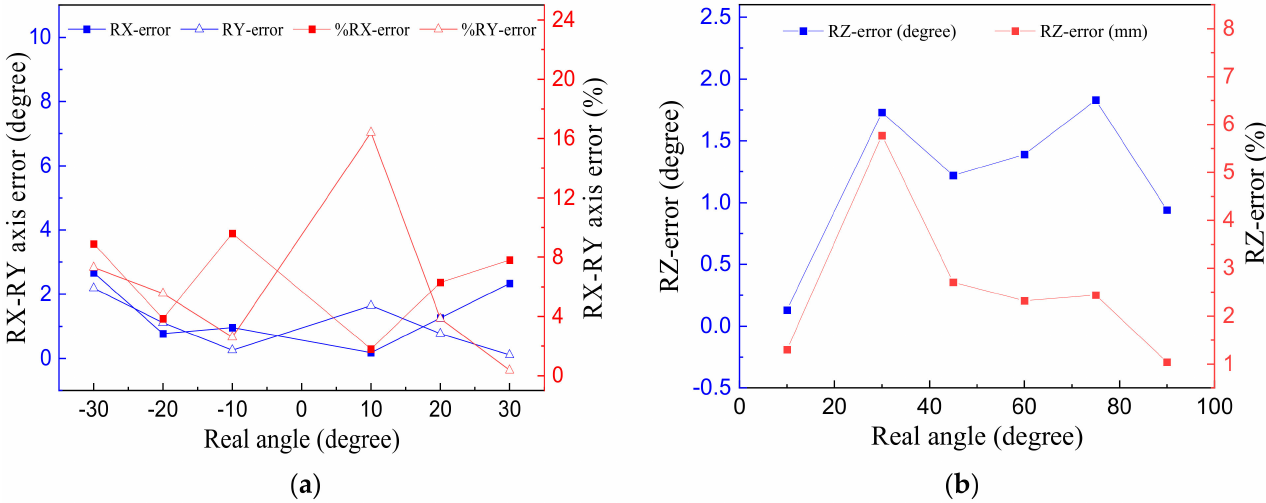
Figure 12. Rotation errors of workpiece modeling at different estimated poses for ( a ) the RX and RY axes and ( b ) the RZ